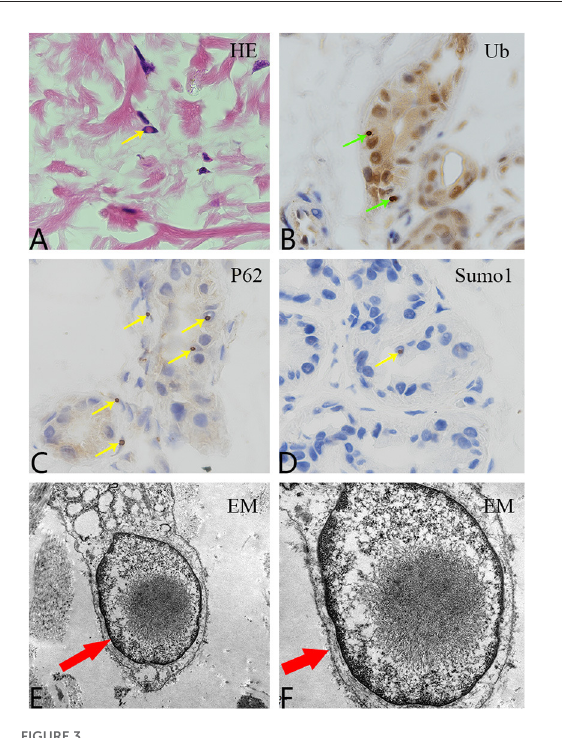
FIGURE3 Pathological examination. (A) Hematoxylin and eosin staining shows eosinophilic inclusion bodies in some skin fibroblasts (100 × , yellow arrow). (B) Anti-ubiquitin immunohistochemical staining. Inclusion bodies are visible in the nuclei of some skin sweat gland cells (100 × , green arrow). (C) Anti-P62 immunohistochemical staining. Inclusion bodies are observed in the nuclei of some sweat gland cells (100 × , yellow arrow). (D) Anti-SUMO1 immunohistochemical staining. Inclusion bodies are visible in the nuclei of some sweat gland cells (100 × , yellow arrow). (E,F) Electron microscopy revealed a circular inclusion body structure in the nucleus of a sweat gland cell (15,000 × and 30,000 × , respectively; red